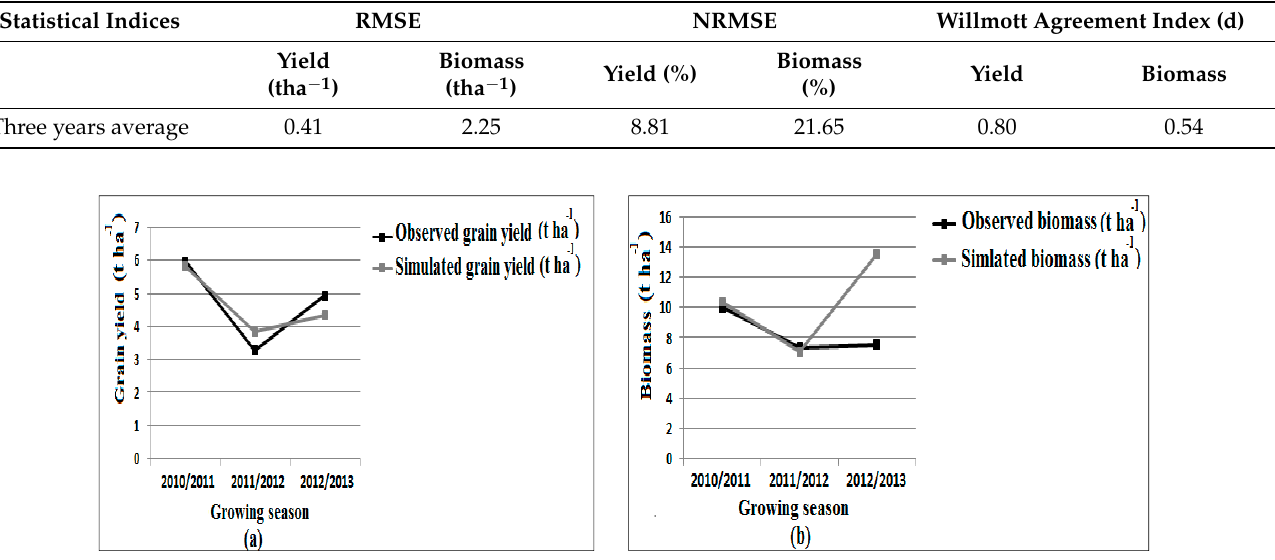
Figure 3. ( a , b ) Comparison between the observed and simulated of Mexicali cultivar’s grain yields and above ground-biomass for the three growing seasons: 2010/2011, 2011/2012 and 2012/2013